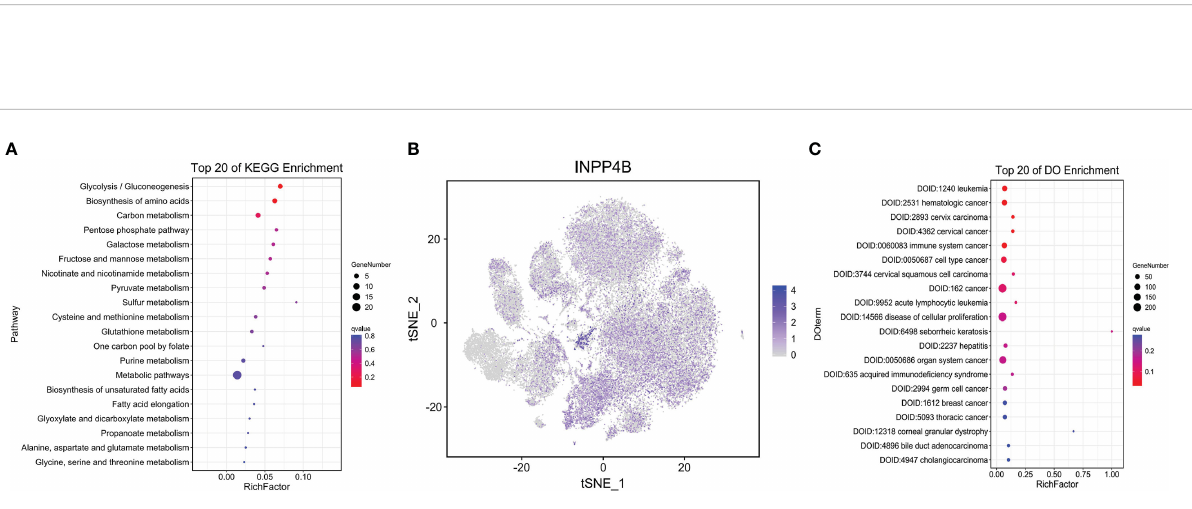
FIGURE 5 T-lymphocyte metabolism analysis. Dot plot depicting the top 20 KEGG pathway in T lymphocytes. Dot sizes represent the gene number, and dot colors represent Q values (A) . t-SNE plot showing the differently expressed gene INPP4B in T lymphocytes. All but clusters 5 and 18 are lymphocytes. Each dot represents a single cell. Colors indicate logarithmic-transformed P values (B) . Dot plot showing top 20 of disease ontology enrichment in T lymphocytes (C) .